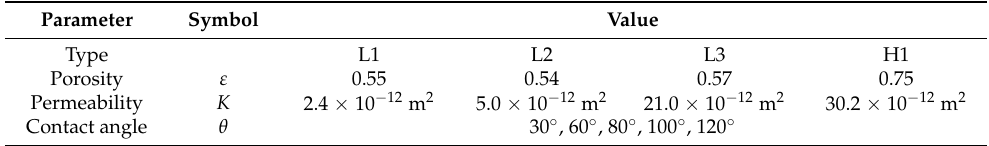
Table 4. PTL properties in the PEMWE